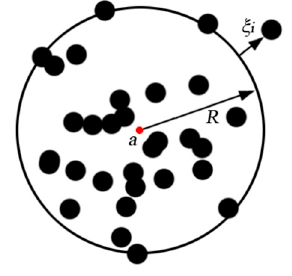
Figure 1. Geometry model of SVDD.